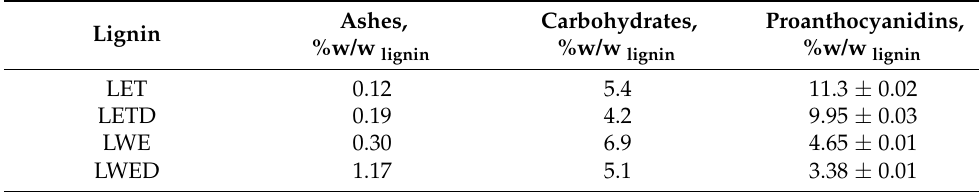
Table 1. Contaminant content (ashes, carbohydrates, and tannins-proanthocyanidins) in isolated lignins (dry weight). LET (lignin pretreated with ethanol/toluene); LETD (lignin pretreated with ethanol/toluene and purified by dialysis); LWE (lignin pretreated with water/ethanol); and LWED (lignin pretreated with water/ethanol and purified by dialysis). Proanthocyanidins, Carbohydrates, Ashes, Lignin %w/w lignin %w/w lignin %w/w lignin LET 0.12 LETD 0.19 LWE